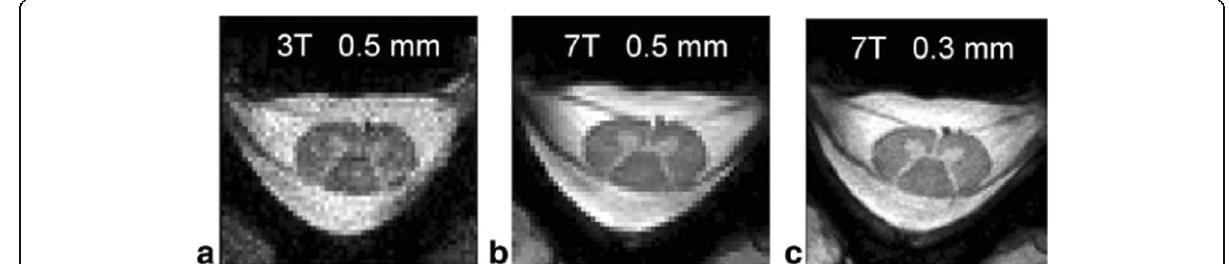
Fig. 4 3 T versus 7-T MRI of C5-C6 spine in a healthy volunteer: 3-T T2 image with 0.5 × 0.5 × 3 mm 3 resolution ( a ); 7-T T2 image with 0.5 × 0.5 × 3 mm 3 resolution ( b ); 7-T T2 image with 0.3 × 0.3 × 3 mm 3 resolution ( c ). Published with permission of the International Society of